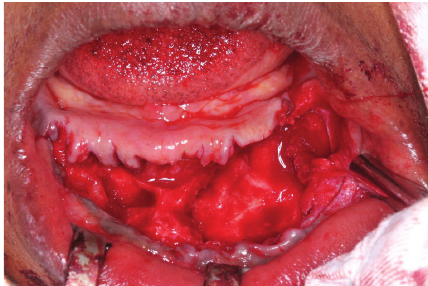
Figure 5: Surgical site after removal of the entire lesion.